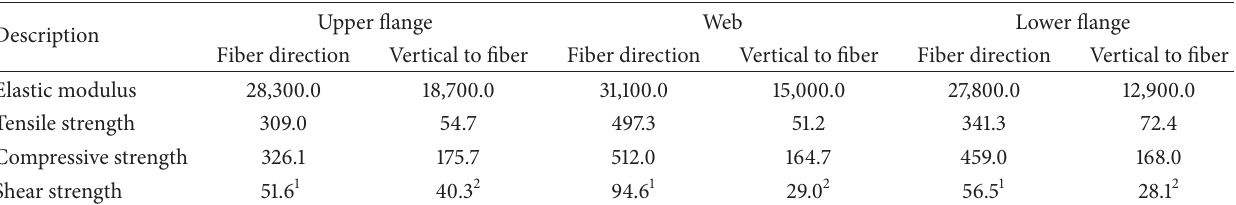
Table 1: Material properties of FRP (unit: MPa).